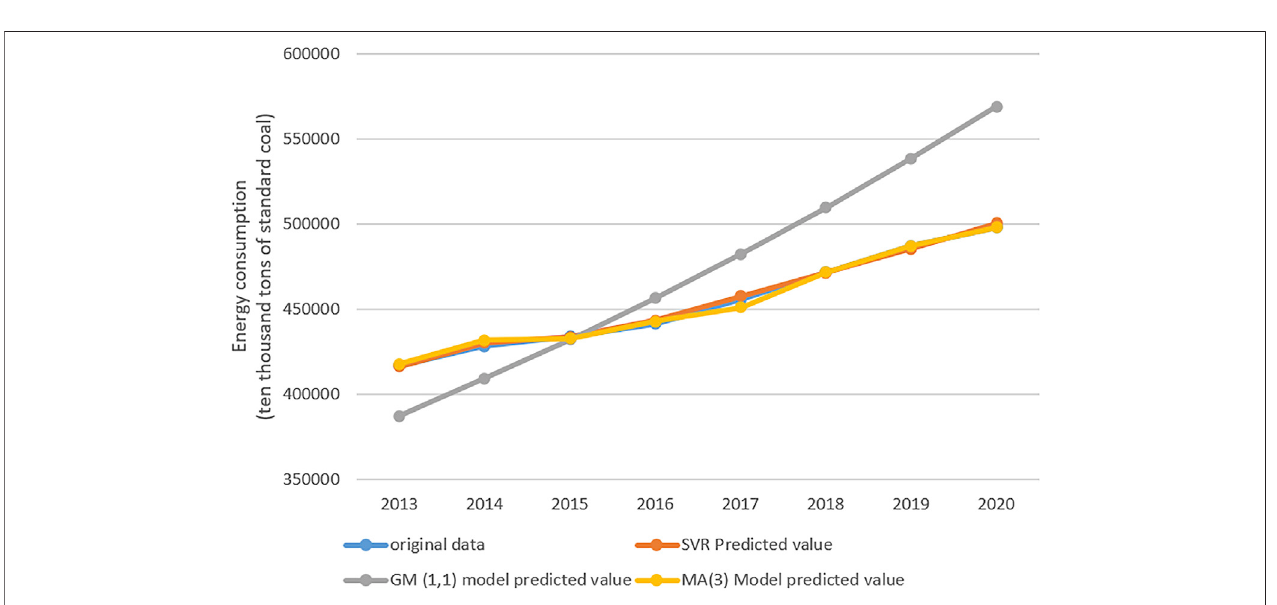
FIGURE 8 | Estimated values of energy